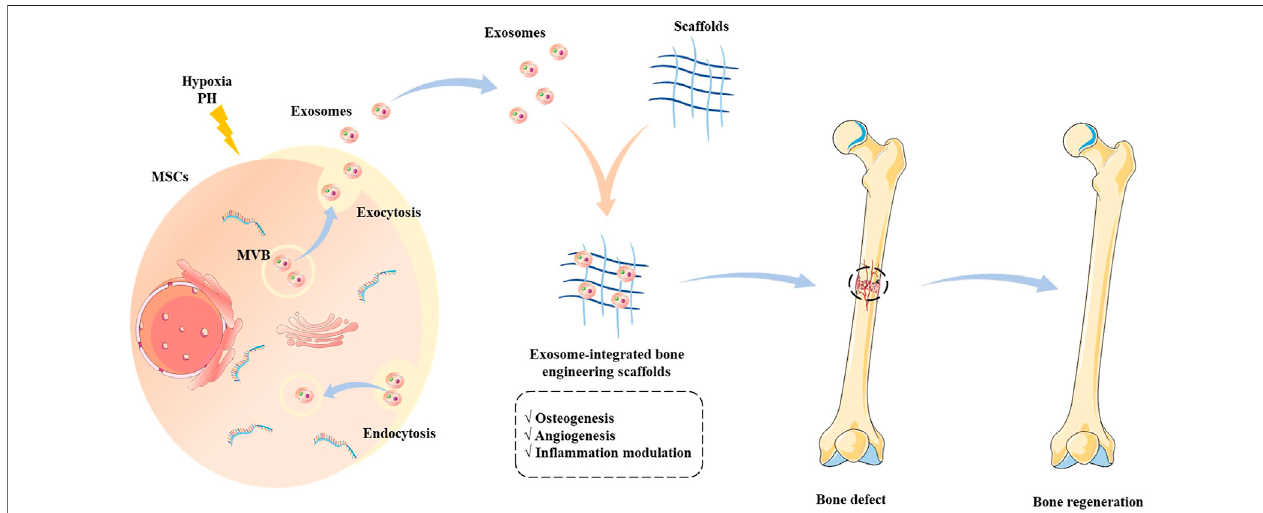
FIGURE2| Schematic illustration ofthe source ofexosomes and the application ofexosome-integrated bone engineeringscaffolds. Theexosomesoriginate from multivesicular bodies, which engage in intercellular communications and deliver biomolecules to regulate the biological functions. The exosome-integrated bone engineering scaffolds possess the capacity for osteogenesis, angiogenesis, and in fl ammation modulation, which promote bone regeneration and repair bone defects.